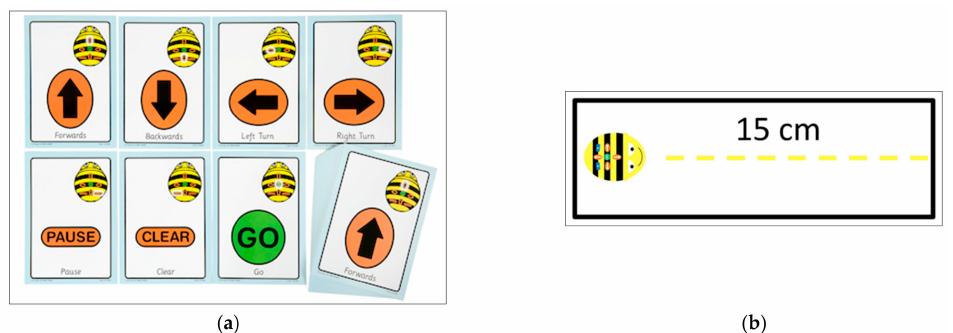
Figure 2. ( a ) Cards to represent the program’s algorithm. ( b ) Rectangle card, a resource that represents the distance that the robot covers with each press of forward or